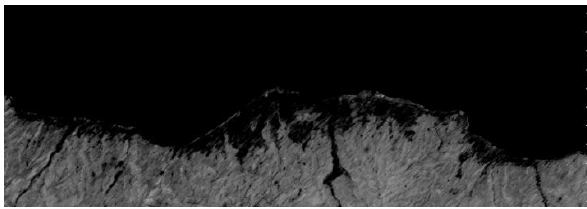
Figure 6. NDVI image - 01.10.2016